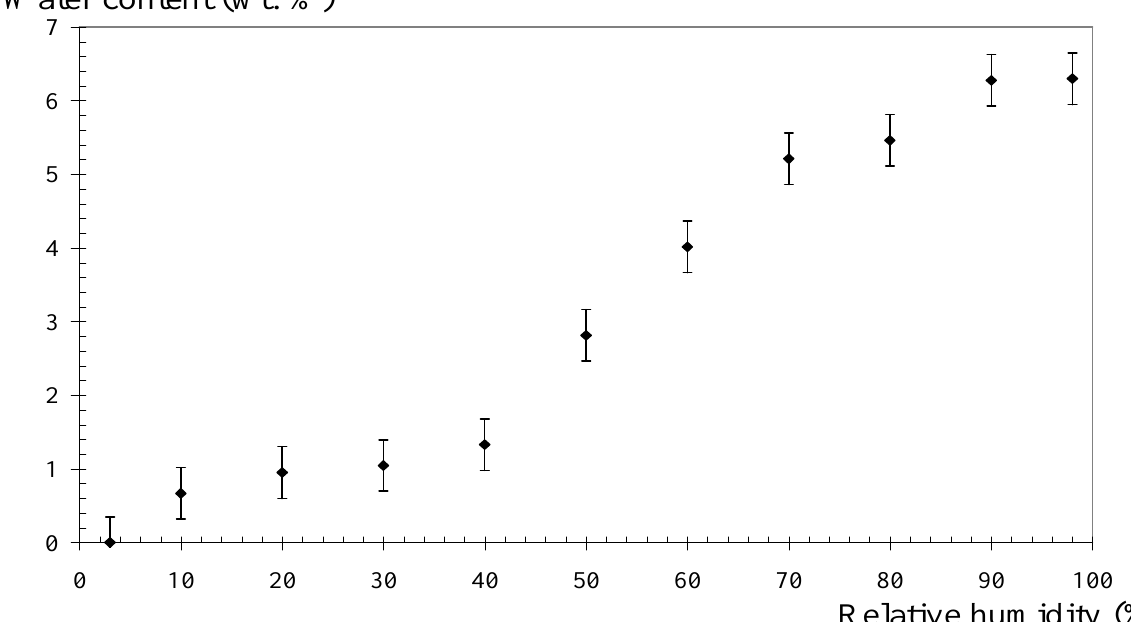
Figure 11. Percentage variation of water content in CB vs. relative